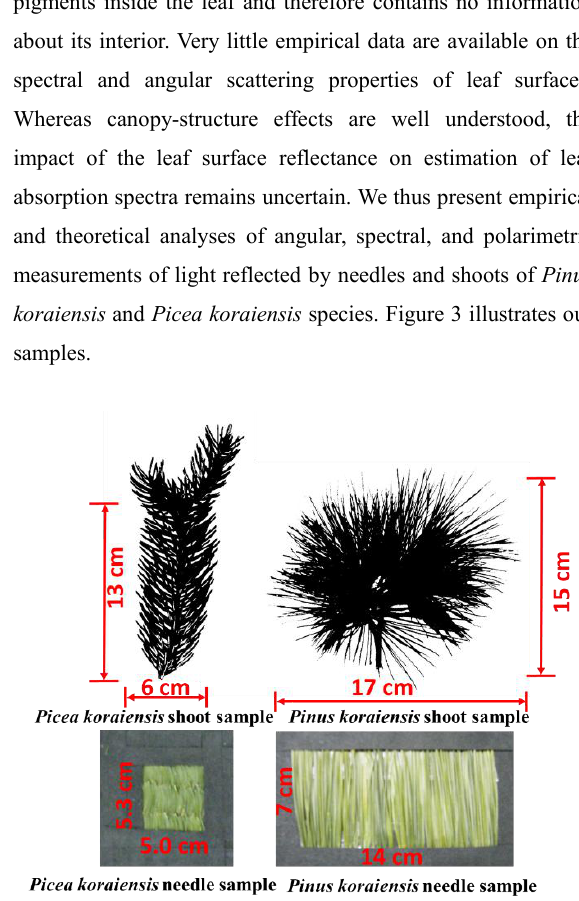
Figure 3. Samples of shoots and needles in the holder window. Sizes of the shoots were 13 cm by 6 cm ( Picea koraiensis ) and 15 cm by 17 cm ( Pinus koraiensis ). Dimensions of the holder windows were 5.3 cm by 5.0 cm ( Picea koraiensis ) and 7 cm by 14 cm ( Pinus koraiensis